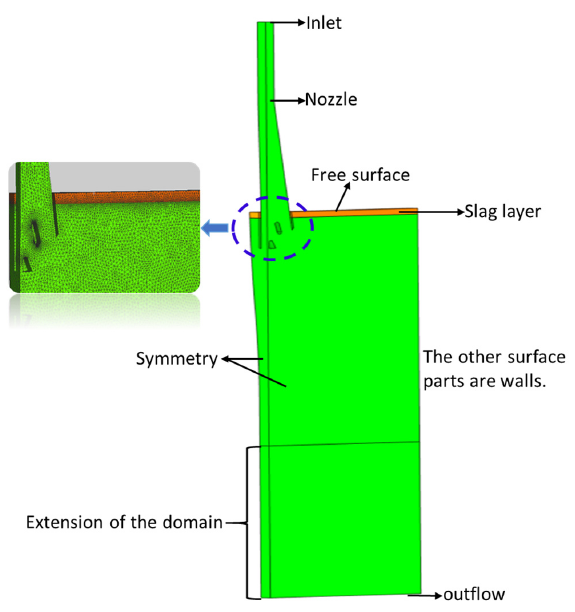
Figure 4. Mesh and boundary conditions for three-dimensional geometric models in fluid domains. The boundary conditions of the FM flow field are as follows: (1). The SEN inlet is defined as the velocity inlet. The velocity as determined by the casting speed is obtained according to the flow rate balance of molten steel.